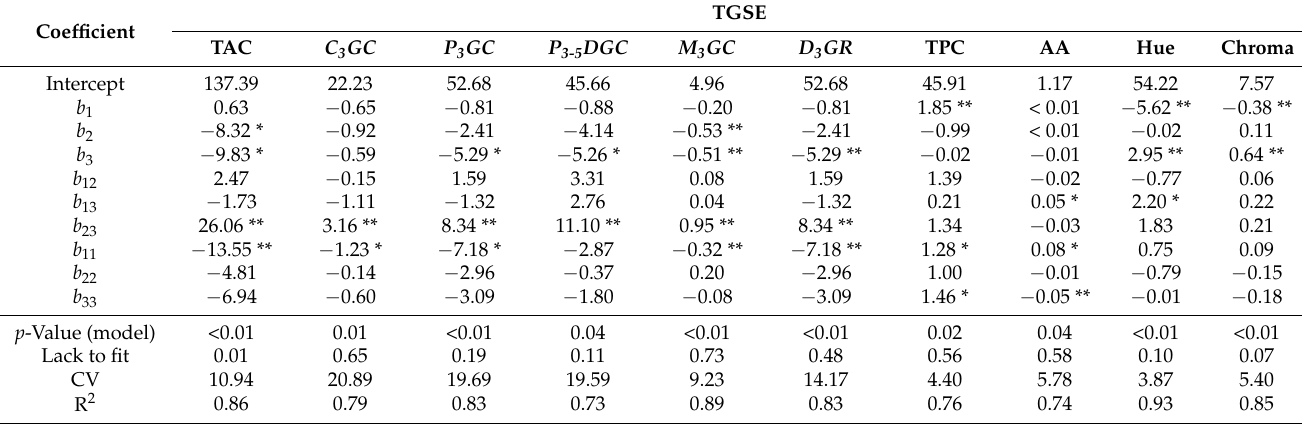
Table 2. Regression coefficients and analysis of variance for chemical properties of TGSE.